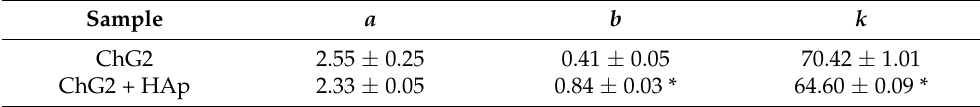
Table 1. Weibull equation constants derived from Figure